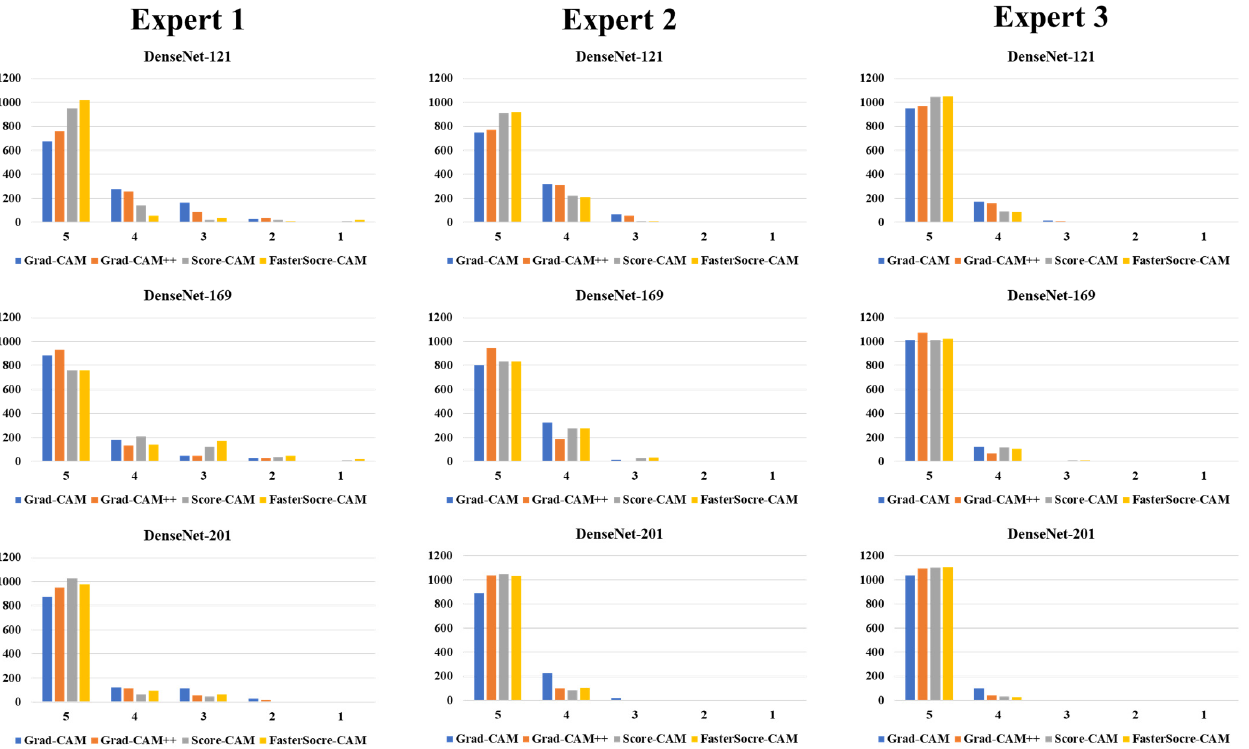
Figure 18. Bar chart representing the MAI.